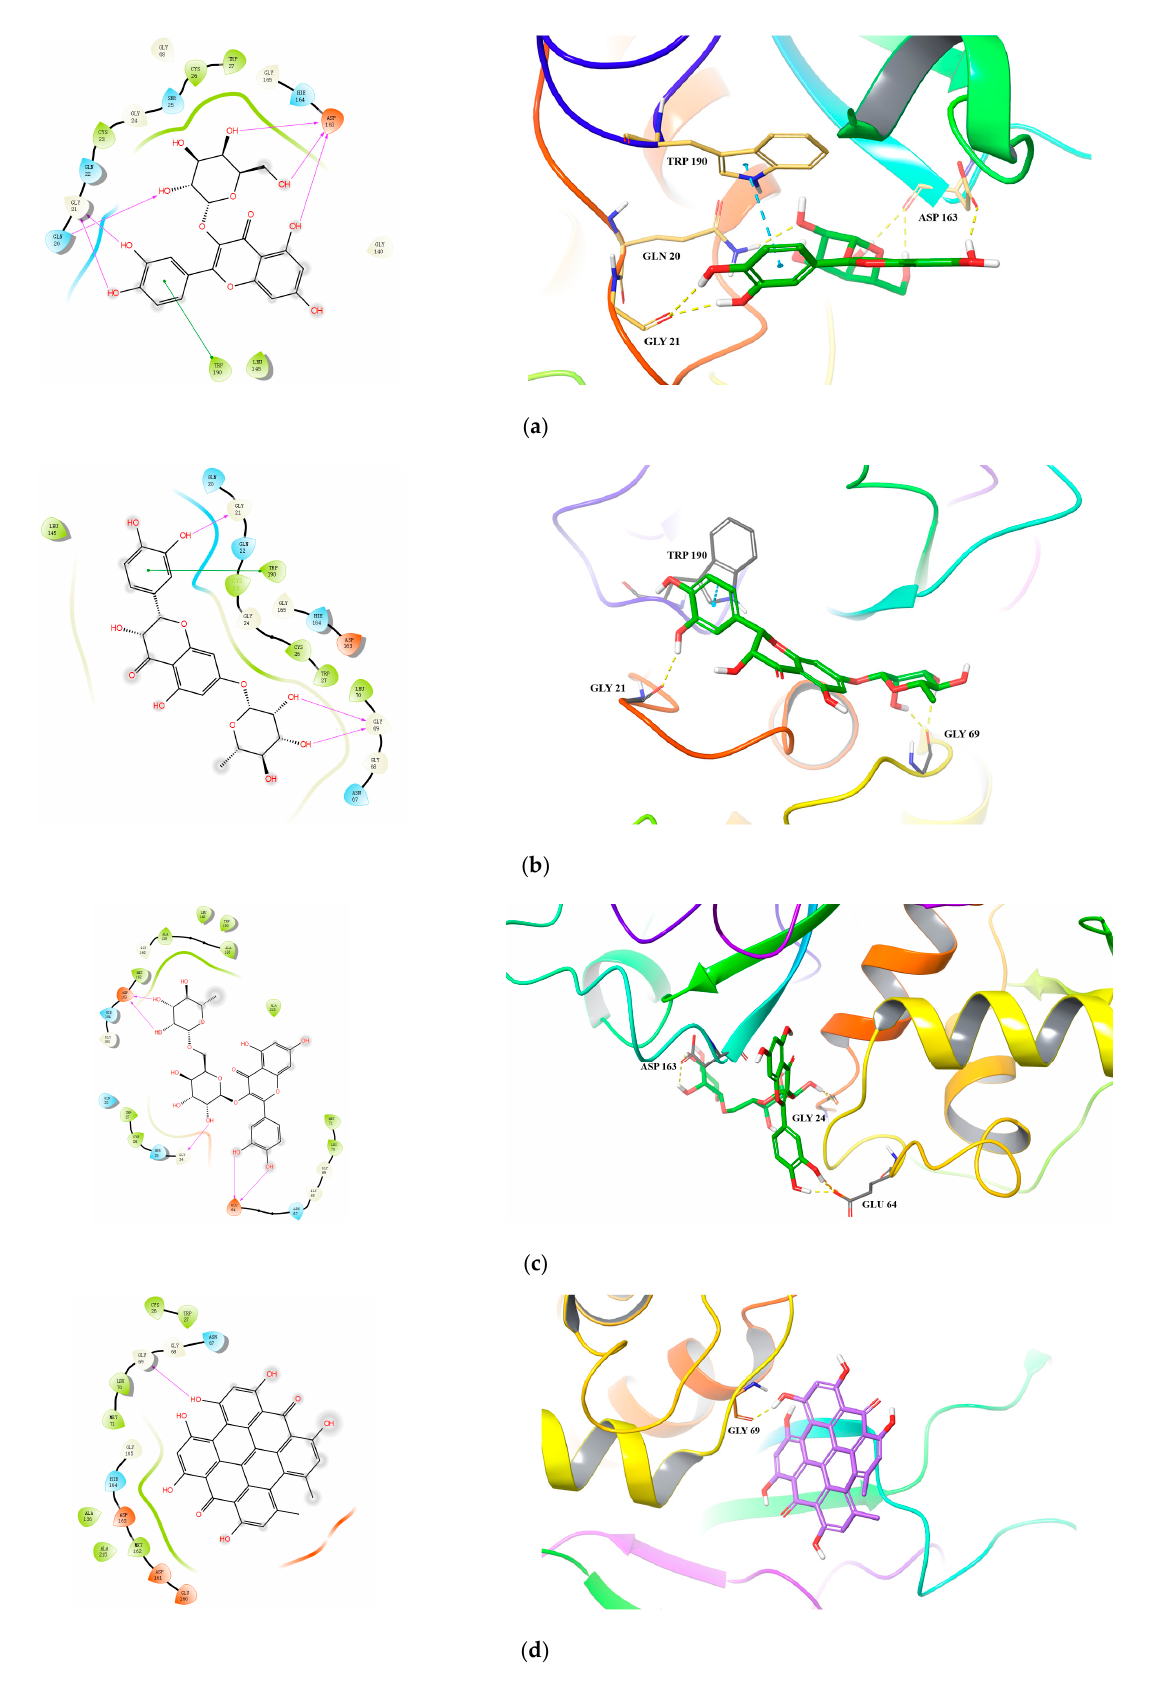
Figure 3. Predicted 2D and 3D binding models of cathepsin L protease with Hyperoside ( a ), Taxifolin-7- O -rhamnoside ( b ), Rutin ( c ) and Hypericin ( d ) by molecular docking. For HIV ‐ 1 PR, all 10 active compounds provided reasonably good docking results (Table 7 and Figure 4). For hyperoside, its hydroxyls and carbonyls formed five hydrogen bonds with residues Arg 8(B), Gly 27(B), Gly 48(B) and Ile 50(B) (Figure 4a). For quercitrin, three hydrogen bonds were formed between its hydroxyl groups and residues Asp 25(A), Asp 30(A) and Gly 48(A) (Figure 4b). For rutin, we identified six hydrogen bonds between its hydroxyl groups and residues Asp 25(A), Ash 25(B), Gly 48(B), Asp 29(B) and Asp 30(B) and a salt bridge with Abg 8(B) (Figure 4c). ( a ) ( b )